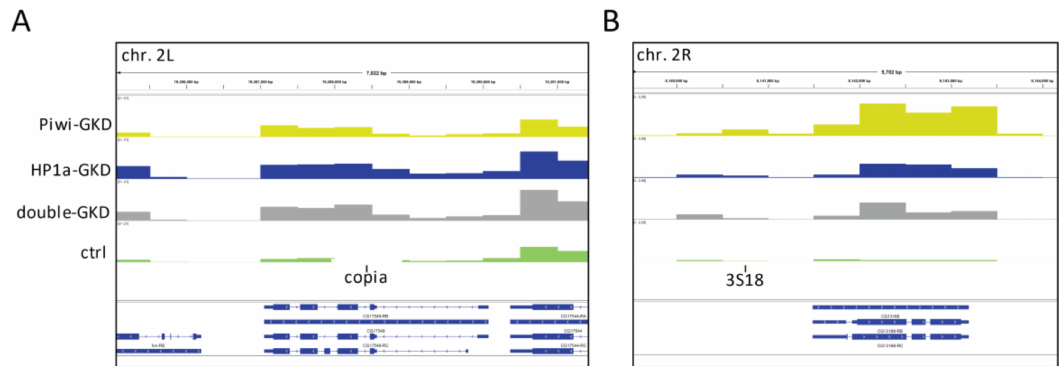
Figure 6. Examples of genes silenced in the germline through Piwi/HP1a-dependent spreading from TE insertions. Screenshots of the genome browser showing RNA-seq signal distribution in 500-bp windows for the CG17549 ( A ) and CG13168 ( B ) genes and neighbouring genomic regions. Insertion sites of copia and 3S18 TEs are indicated. Green, yellow, blue and grey tracks show transcript profiles in the Ctrl, Piwi-GKD, HP1a-GKD and double-GKD,